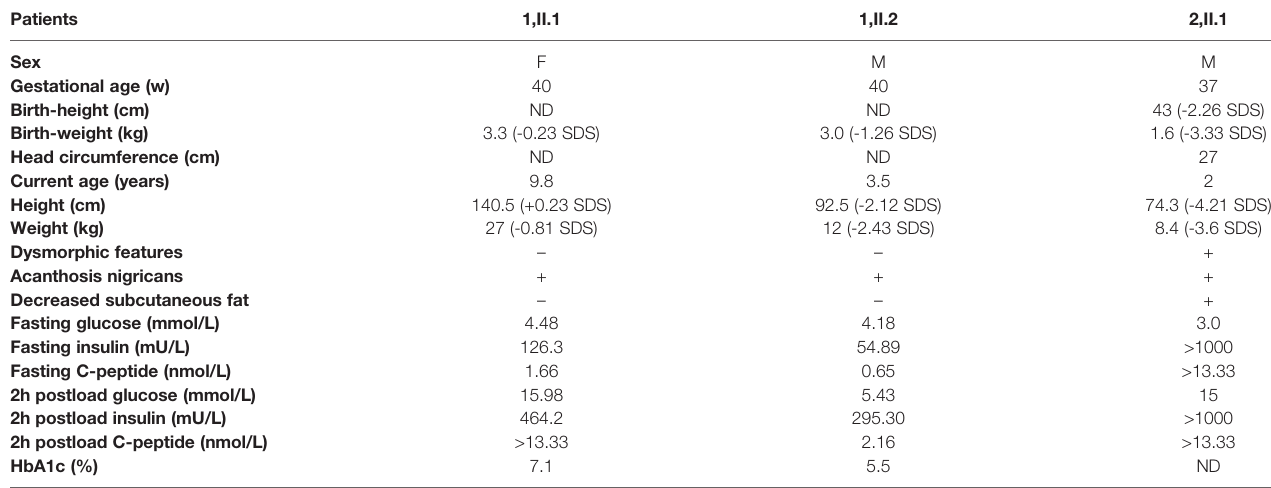
TABLE 1 | Clinical features and laboratory data of the three patients.